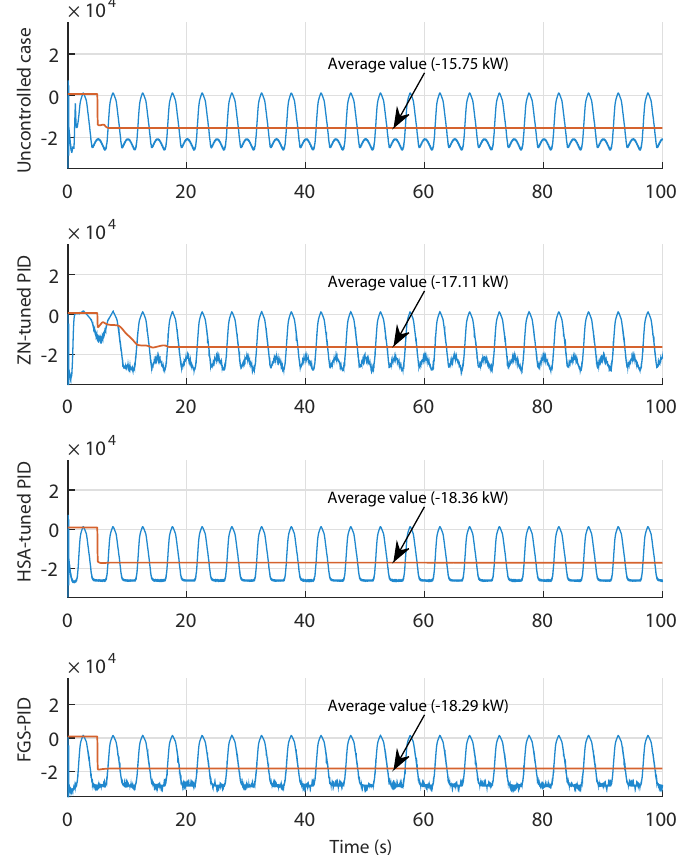
Figure 20. Generated power with different control methodologies in regular